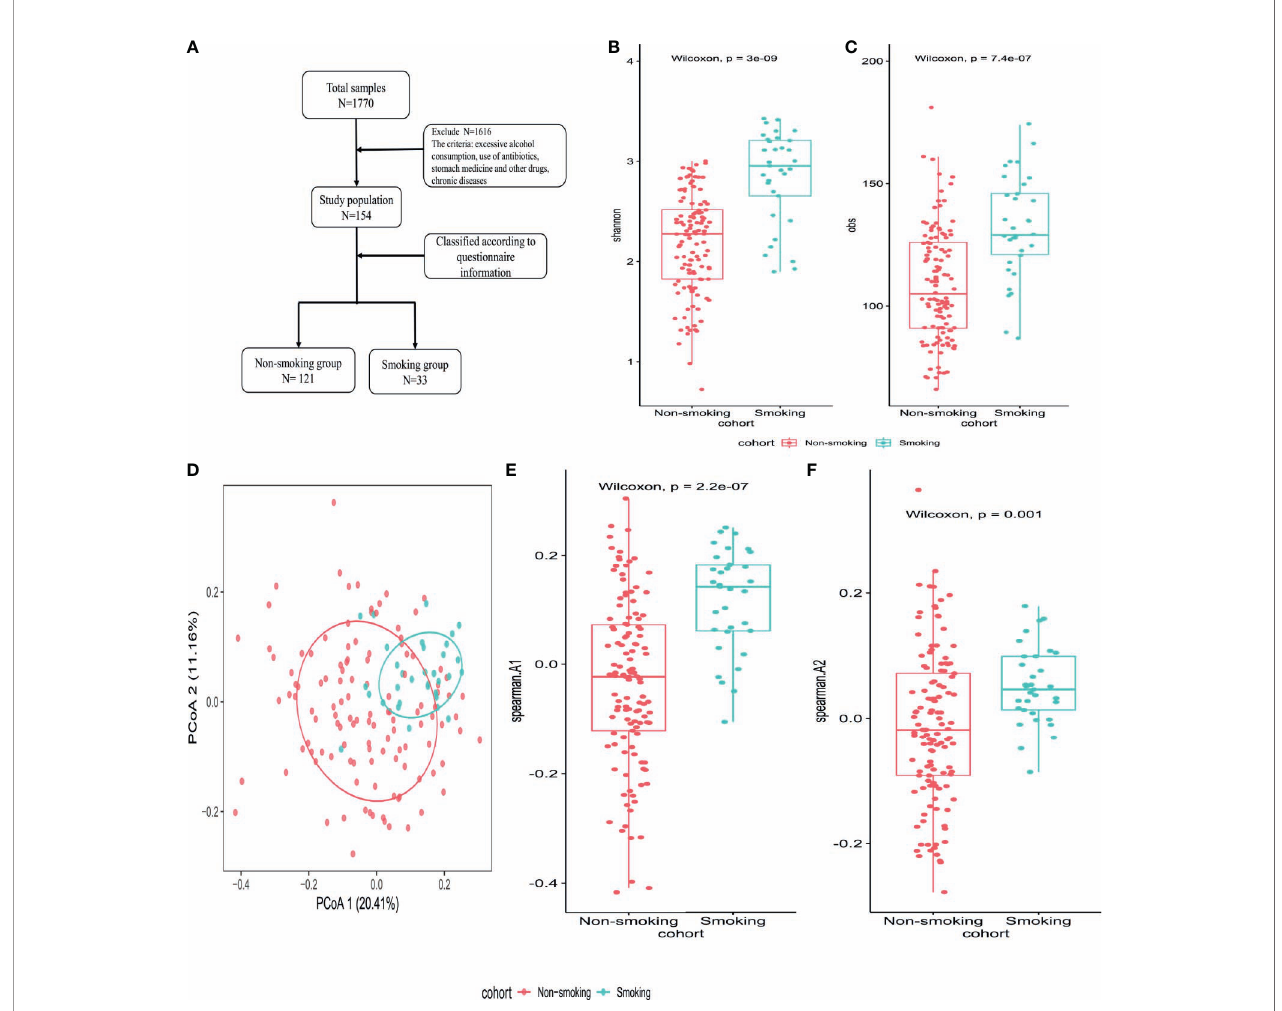
FIGURE 2 | Microbiome composition and diversity (A) enrollment fl ow; (B, C) Shannon and obs indexes were used to analyze a -diversity between smokers (N=33) and non-smokers (N=121); (D) b -diversity using PCoA diagrams of the Spearman distance; (E, F) differences in the fi rst and second principal components between smokers and non-smokers by Spearman